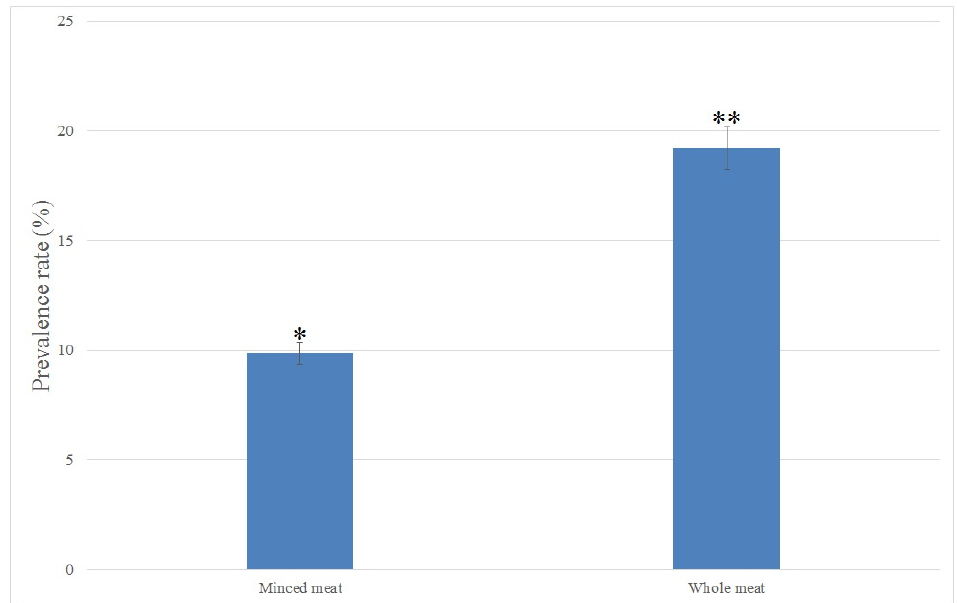
Figure 1. Prevalence rates of C. perfringens in the different raw meat samples. * and ** indicate significant differences ( p < 0.05, chi-square test).